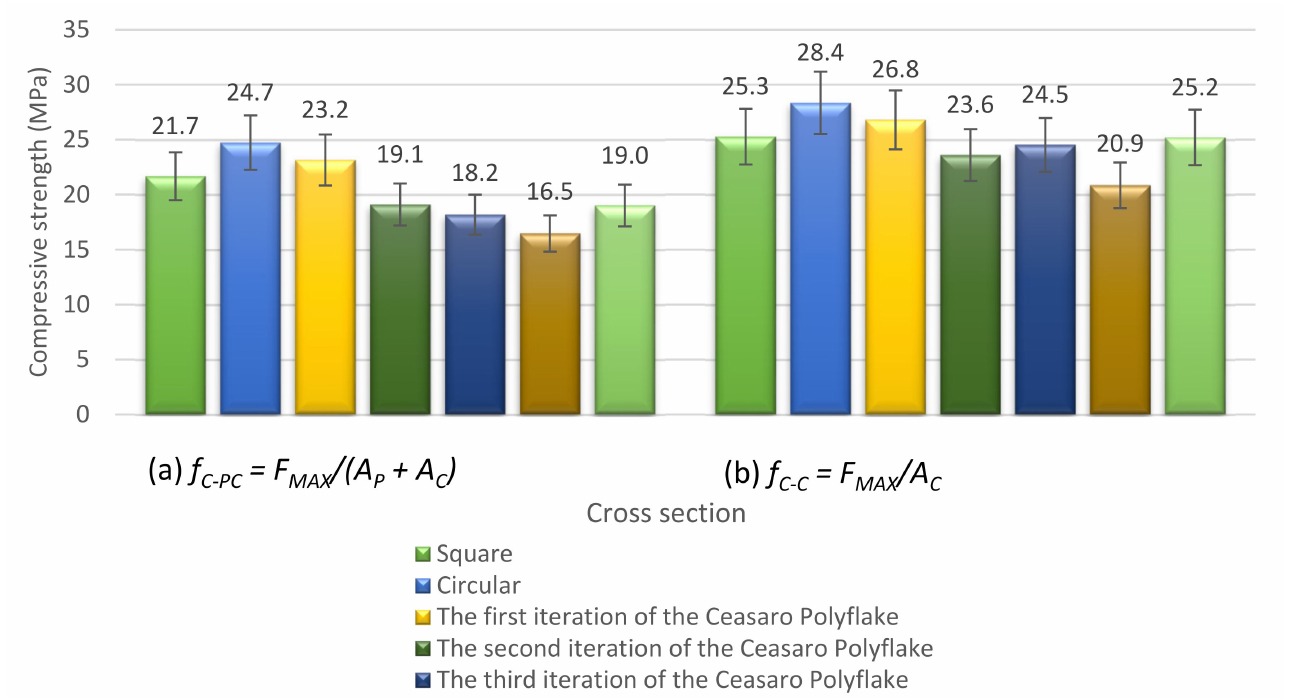
Figure 7. Compressive strength of tested concrete–plastic